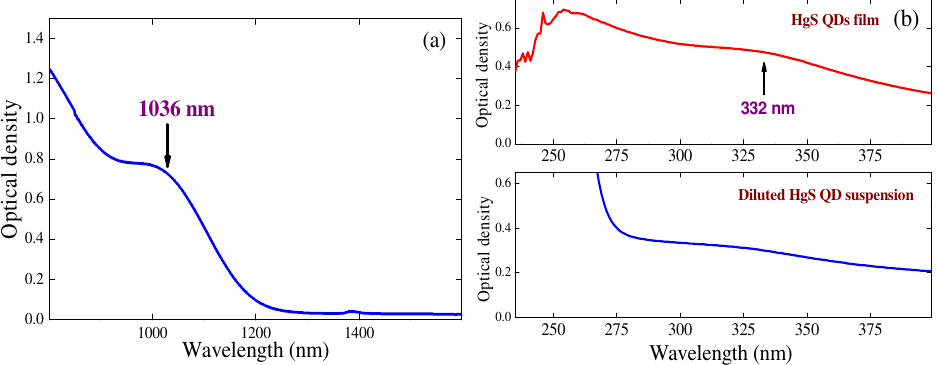
Figure 2. Absorption spectra of HgS QD film and suspension. ( a ) Optical density of the suspension contained in 1 mm thick silica glass cell in the near infrared range. ( b ) Upper panel: UV absorption spectrum of the 70 nm thick film contained HgS QDs. Bottom panel: UV absorption spectrum of the diluted suspension.